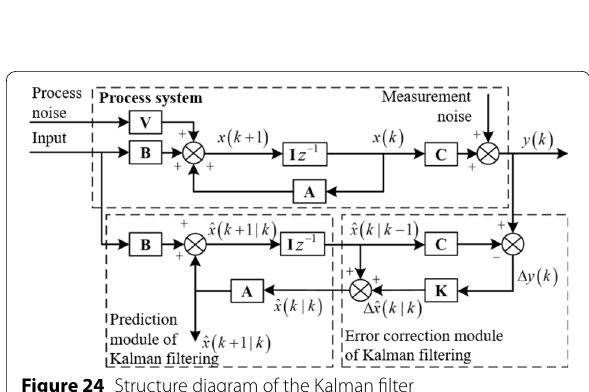
Figure 24 Structure diagram of the Kalman